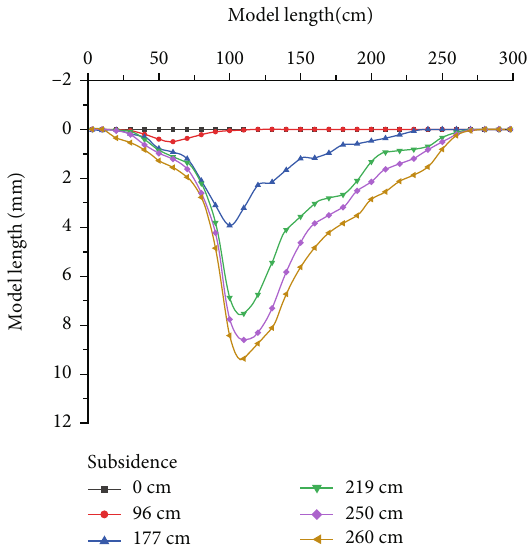
Figure 10: Subsidence characteristics of top of mining model of the 2301 working